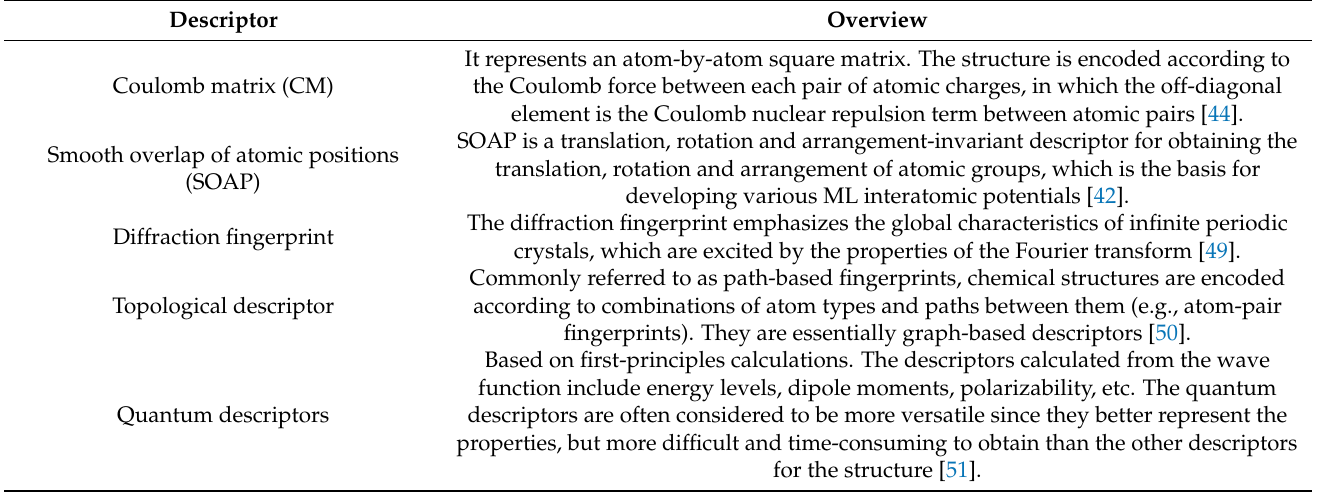
Table 2. Overview of some common